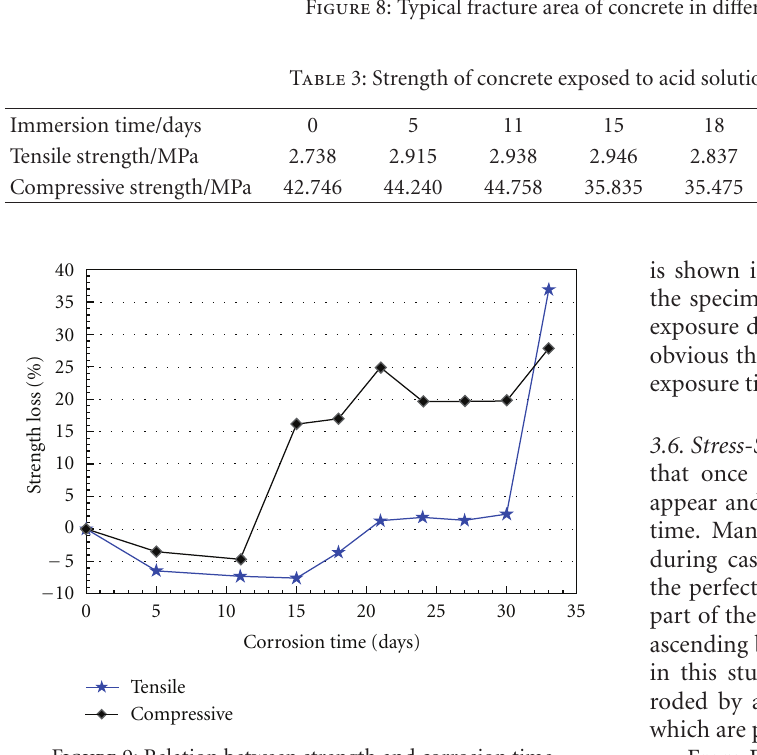
Figure 9: Relation between strength and corrosion